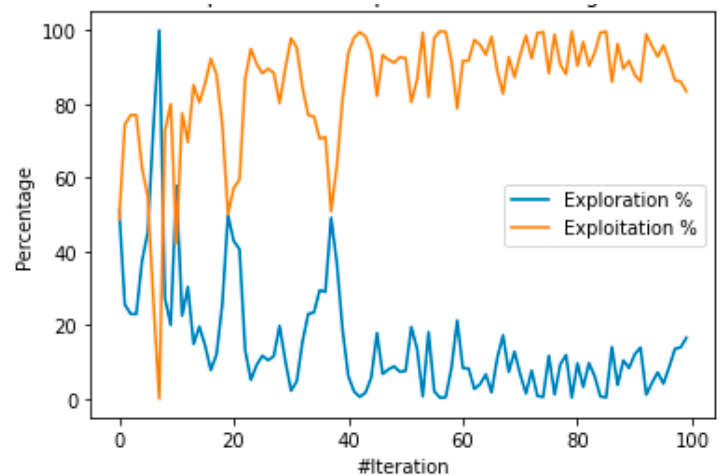
Figure 3. Exploration exploitation balance of the DE algorithm.